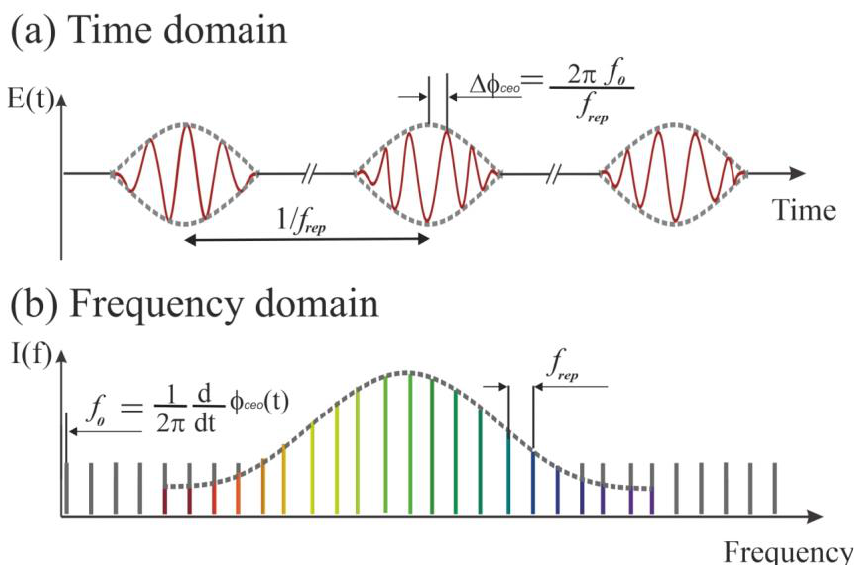
Figure 2. Time ( a ) and frequency ( b ) domain representation of a mode-locked laser output. The frequency comb of longitudinal modes corresponds to a train of short pulses spaced by the cavity round-trip time 𝑡 𝑟𝑡 = 1 𝑓 𝑟𝑒𝑝 ⁄ round-trip time t rt = 1/ f rep